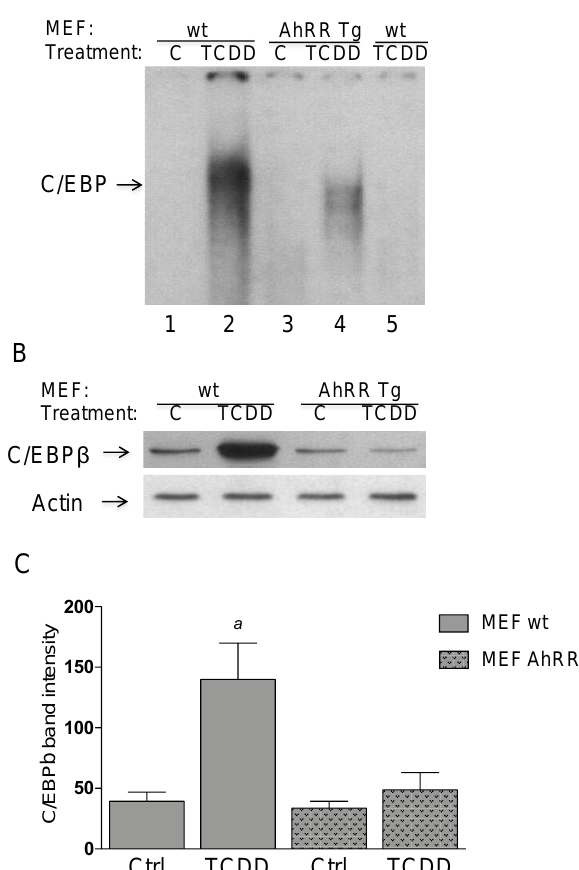
Figure 4. AhRR represses the levels and activity of C / EBP. ( A ) Repressed DNA binding activity to a C / EBP consensus element in AhRR Tg MEF compared to wt MEF. MEF from wt (lanes 1 and 2) and AhRR Tg mice (lanes 3 and 4) were treated with 1 nM TCDD (lanes 2 and 4). After 4 h nuclear proteins were extracted. For specificity a 200-fold molar excess of unlabeled probe was added as competitor (lane 5). ( B ) Repressed protein level of C / EBP β in AhRR Tg MEF. MEF from wt and AhRR Tg mice were treated with 1 nM TCDD for 4h. Nuclear proteins were extracted and protein level of C / EBP β was determined by western blot. ( C ) densitometric evaluation of band intensities of the western blot bands of MEF wt (open bars) and MEF AhRR Tg (shaded bars) is presented. Results of three separate experiments are shown as mean values ± S.D. a significantly di ff erent from control cells ( p < 0.05).